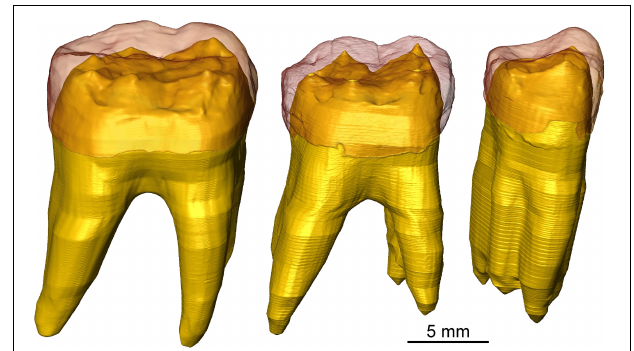
FIGURE 5 | n- µ CT-based 3D surfaces of the virtually extracted right p4, m1, and m2 of the UR 501 mandible, with the reddish enamel in semi-transparency revealing details of the EDJ and the crown and radicular dentine rendered in yellow.